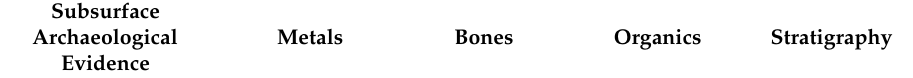
Table A1. Mean values of soil loss per country level for each type of subsurface material. Values close to 1 indicate poor status of preservation, values close to 2 indicate fair conditions of and values close to 3 good preservation